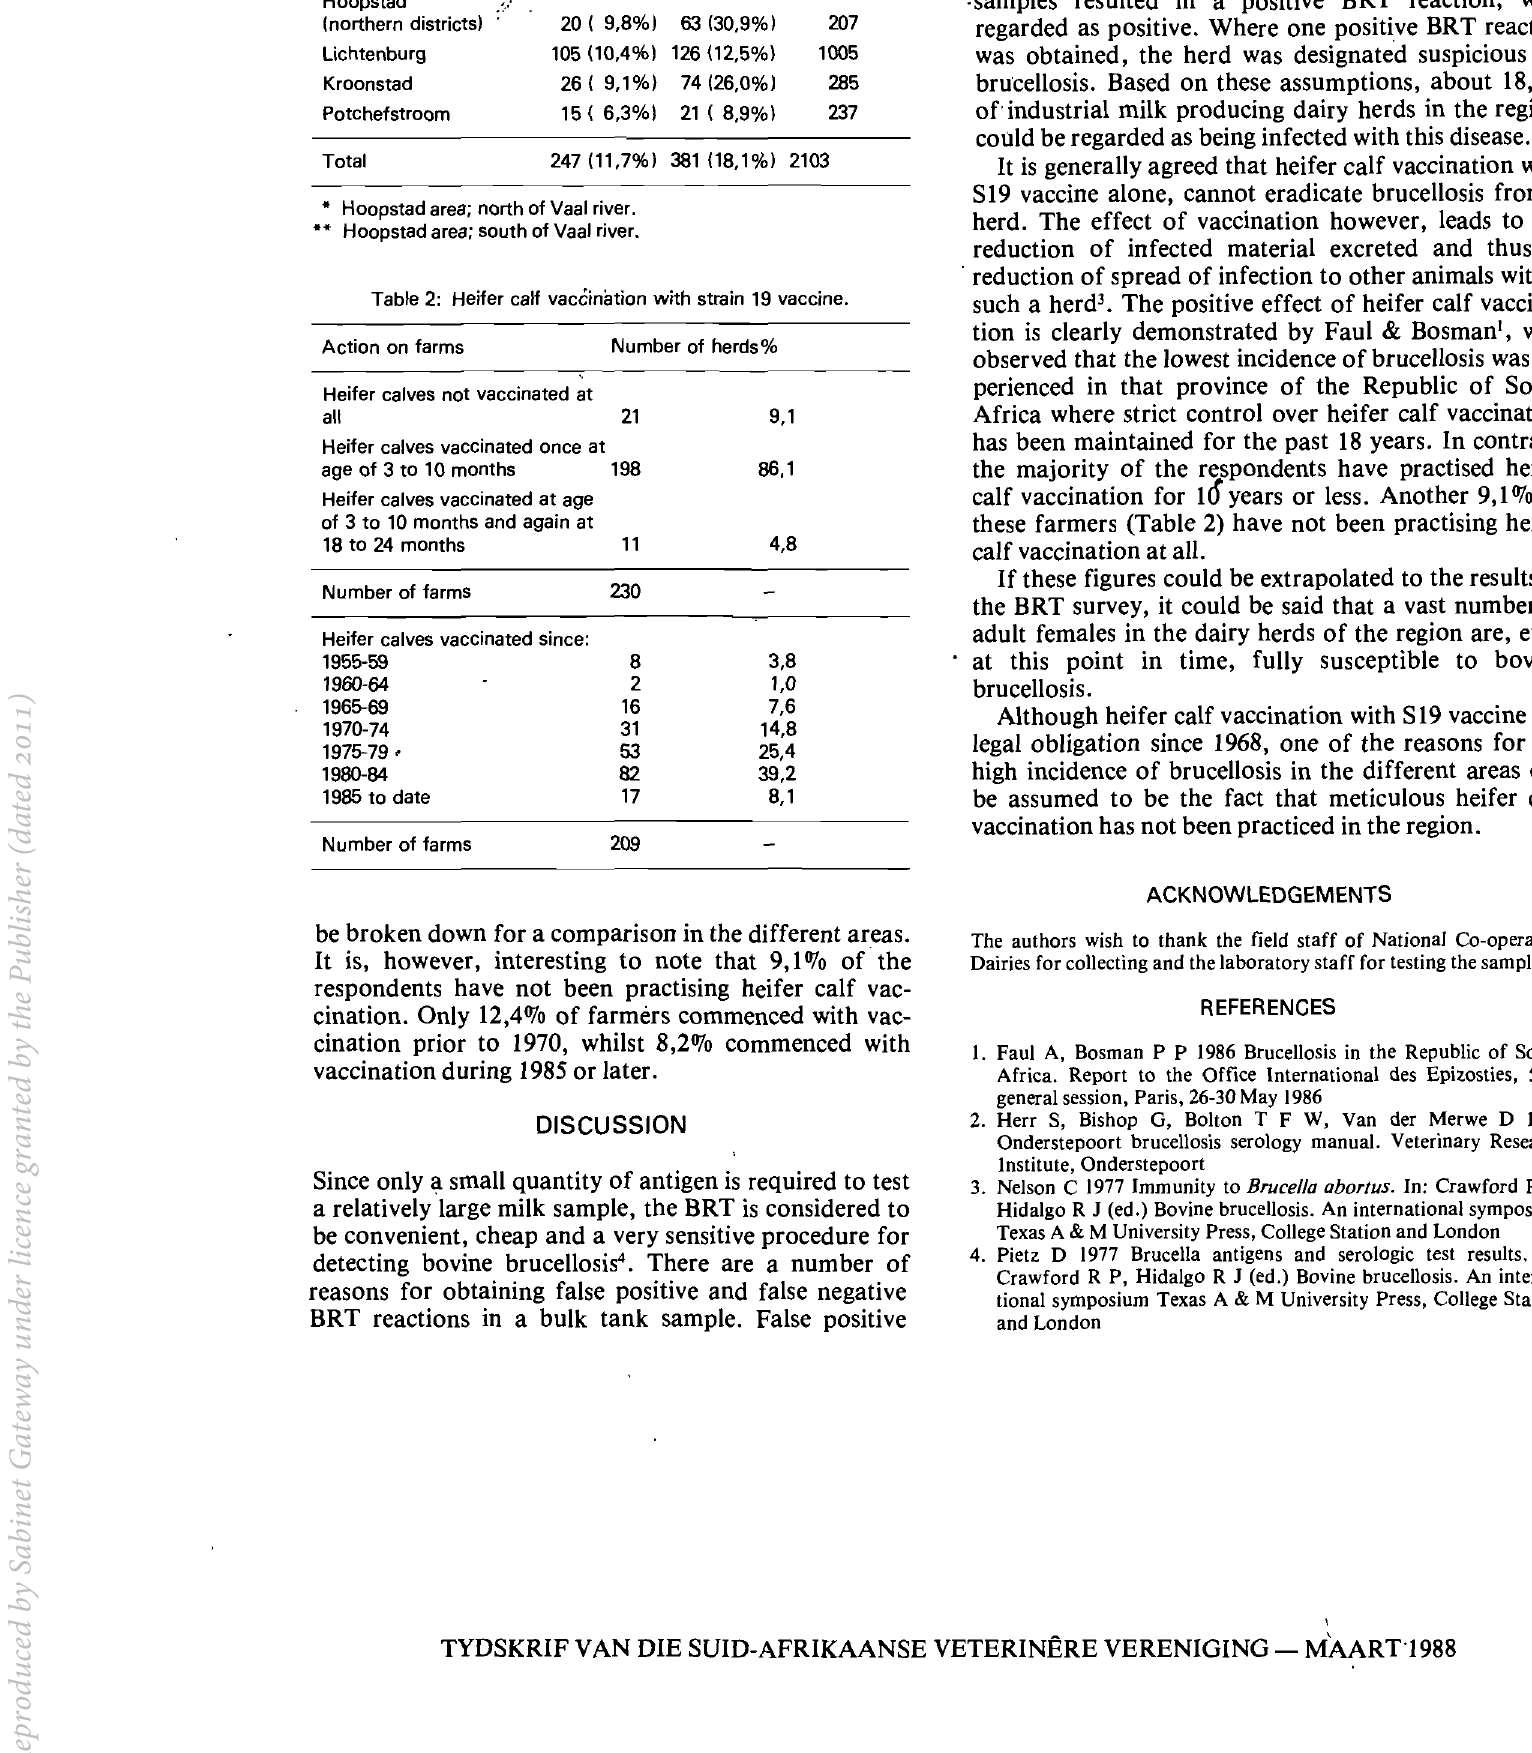
Table 1: Incidence of bovine brucellosis in industrial milk producing herds Number of herds Number Area one sample both samples of positive positive Farms Hoopstad ** (southern districts) 81 (2),9%) 97 (26,3%) 369 .. ,- Hoopstad * . ~.:: (northern districts) 20 ( 9,8%) 63 (30,9%) 207 Lichtenburg